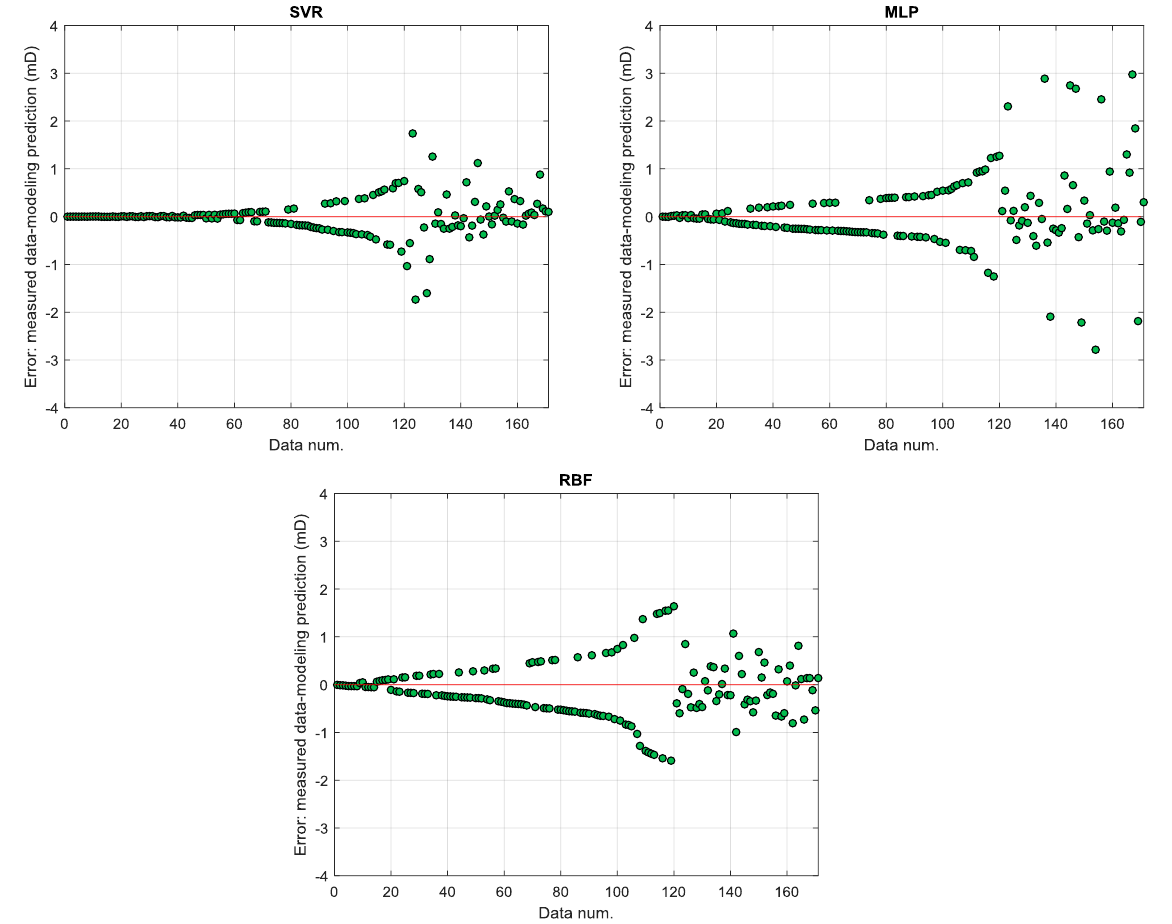
Figure 11. Relative deviations of DT, RF, SVR, MLP, and RBF models